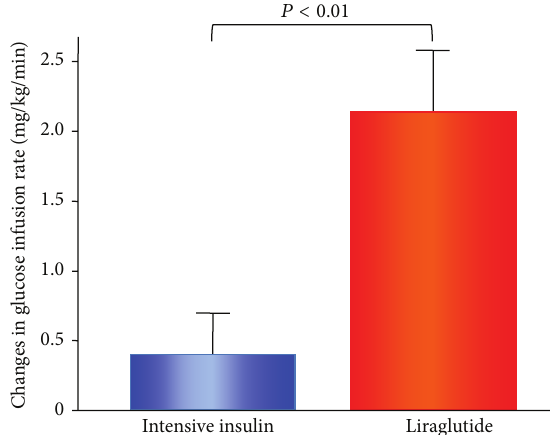
Figure 2: Changes in glucose infusion rate in euglycemic- hyperinsulinemic clamp after the 4-week intensive insulin-therapy and liraglutide-therapy. Bar graphs represent the amount of change in glucose infusion rate (GIR) as the mean and standard error of mean in patients with intensive insulin-therapy ( 𝑛 = 15 ) and liraglutide-therapy ( 𝑛 = 16 ). Change in GIR (mg/kg/min) = (GIR after 4 weeks of therapy) − (GIR at admission). The intergroup comparisons of the changes in GIR values in liraglutide-therapy were significantly higher than those in intensive insulin-therapy (unpaired 𝑡 -test, 𝑃 < 0.01 ).